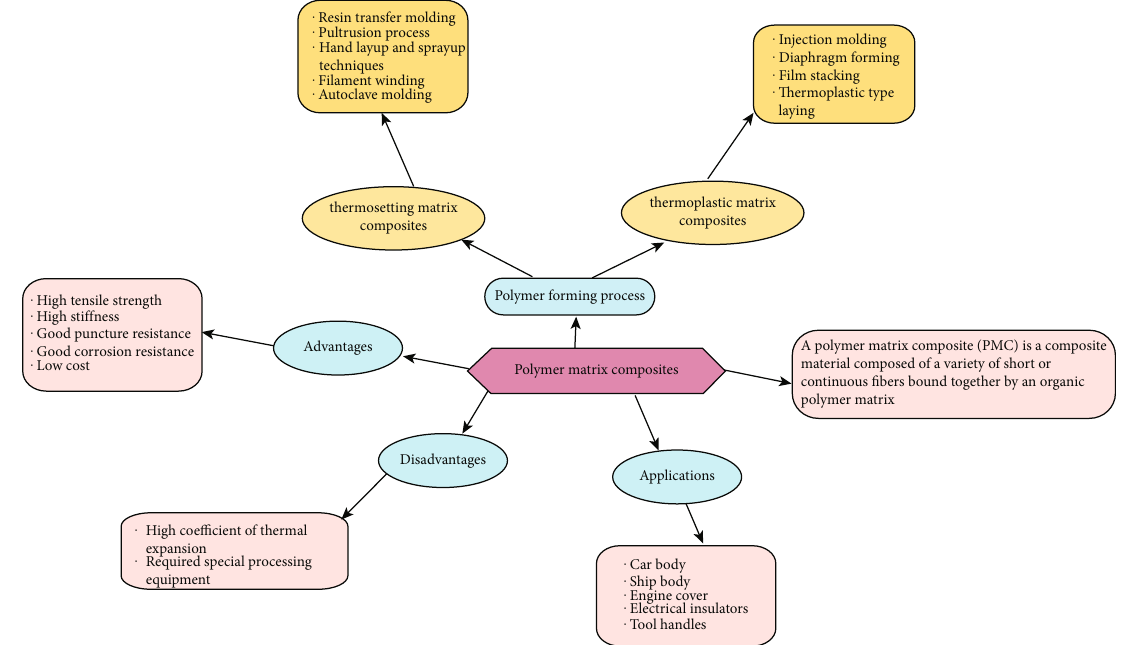
Figure 1: Schematic diagram of polymer matrix composite advantages and